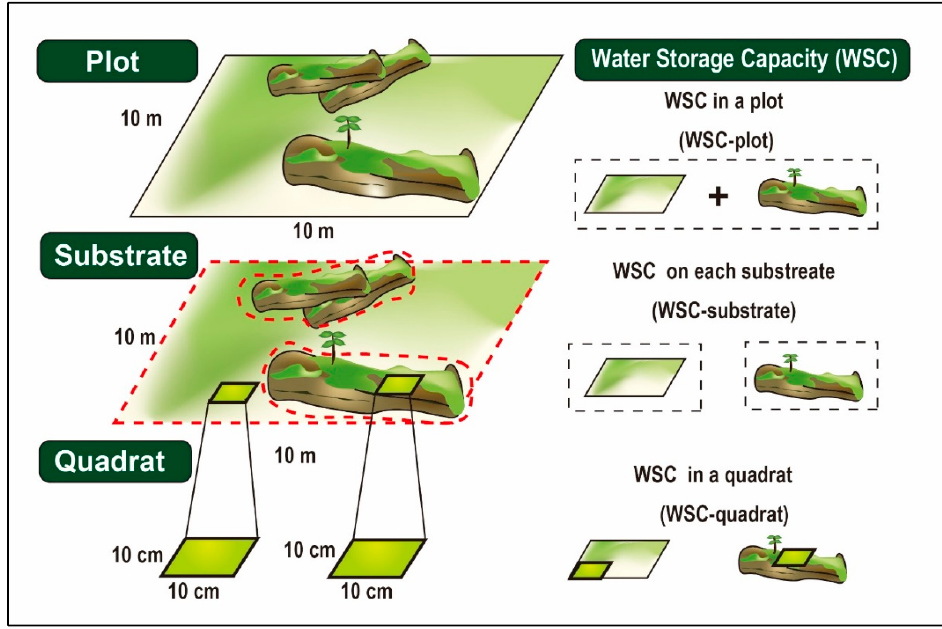
Figure 2. Schematic showing the hieratical evaluation of the water storage capacity of bryophytes. 2.3. Water Storage Capacity at Quadrat, Substrate, and Plot